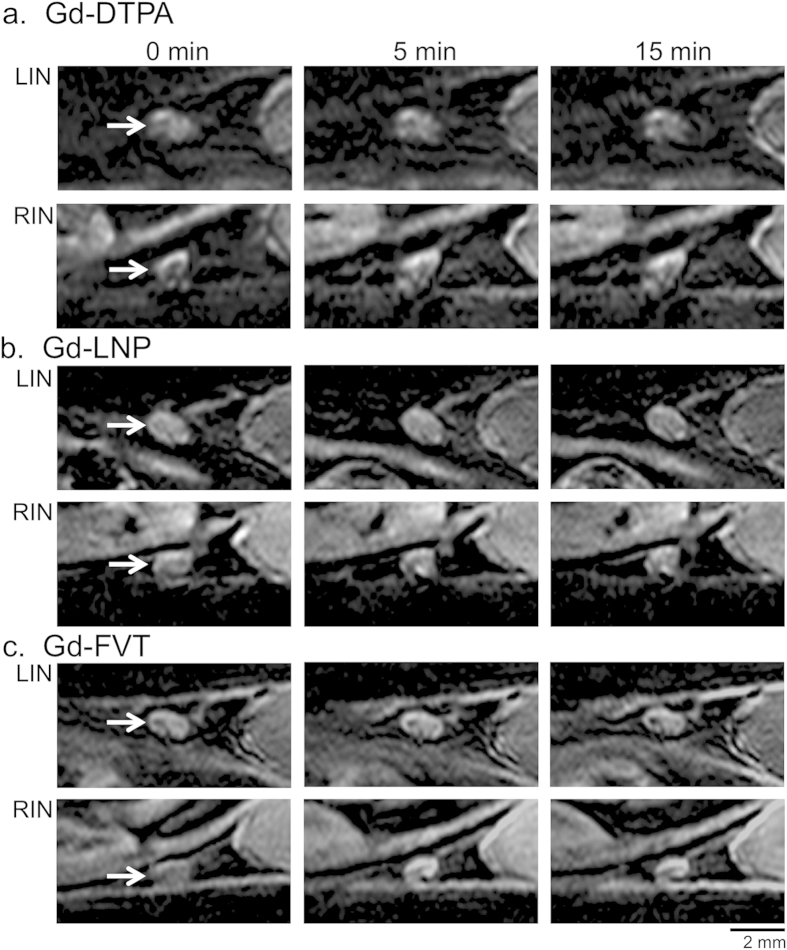
Contrast agent uptake in the inguinal lymph nodes.(a) The uptake of Gd-DTPA into the LIN and RIN (arrows) is shown in single slice examples. Gd-DTPA uptake is minimally detected in the RIN, and not in the LIN. (b) Gd-LNP is taken up into the RIN but not into the LIN. (c) Gd-FVT contrast agent accumulates in the RIN and LIN, at 5 and at 15 min after injection. Scale bars are indicated.